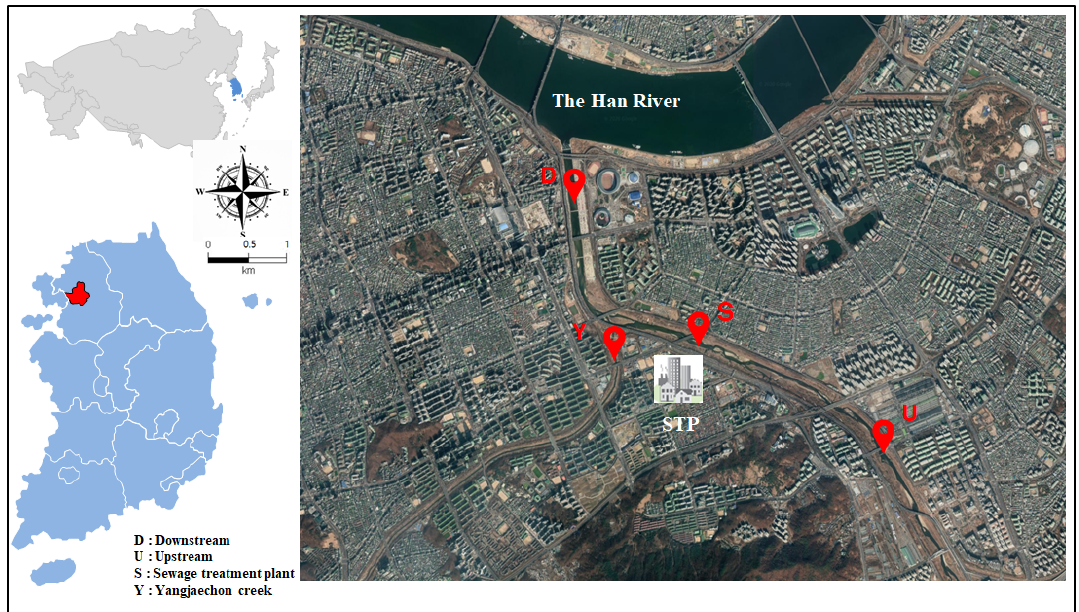
Figure 1. Location of sampling sites (upstream and downstream of Tanchon stream flowing to the Han River, Yangjaechon Creek and near the sewage treatment plant effluent). The satellite map was obtained from google map (www.google.co.kr/maps).